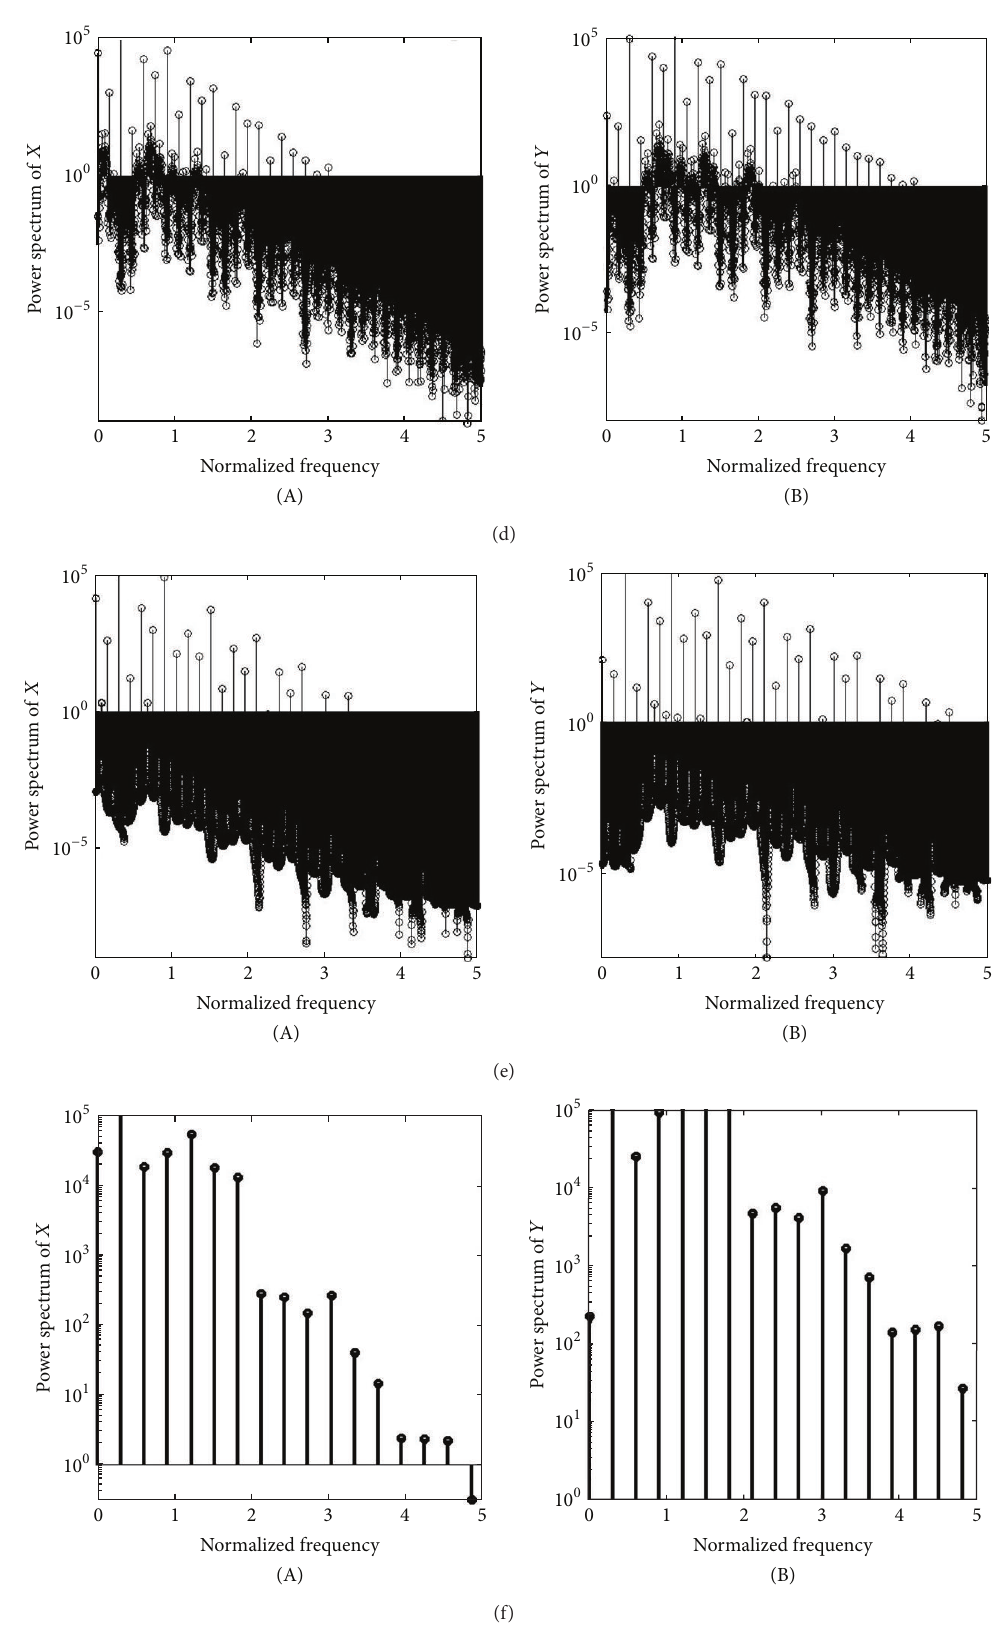
Figure 2: Power spectra of coronary artery system at 𝐸 = (a) 0.1, (b) 0.3, (c) 4.3, (d) 4.5, (e) 5.9, and (f)